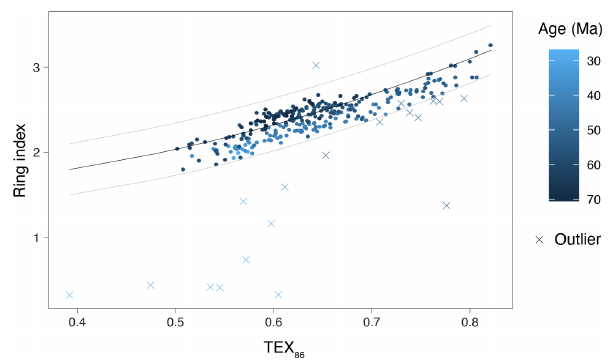
Figure 5. Ring index (RI) vs. TEX 86 . Dots indicate RI / TEX 86 values for samples that are retained; crosses indicate samples that are discarded (see Fig. 4). Color of all data points indicates age of the sample, from Maastrichtian (dark blue) to Oligocene (light blue). Black and gray curves represent the RI / TEX 86 ratio in mod- ern core-top samples and the 95% confidence interval, respectively (see Table